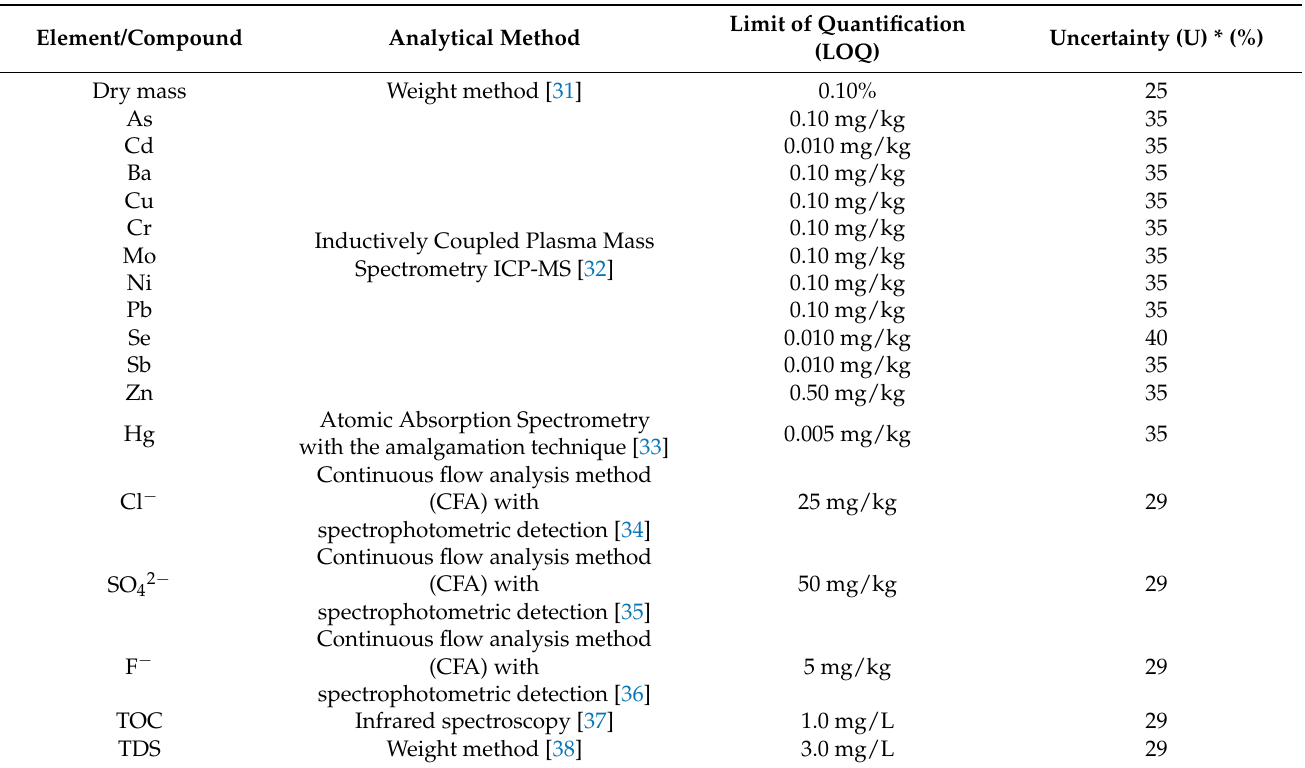
Table 1. Analytical methods used for selected elements and compounds